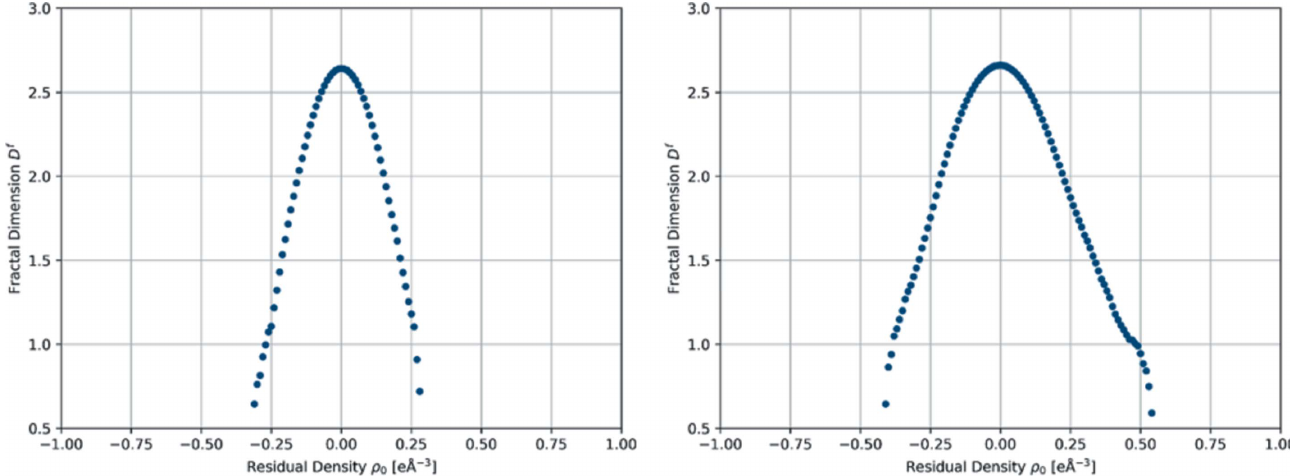
Figure 2 Fractal dimensionality plots for 1 (left) and 2